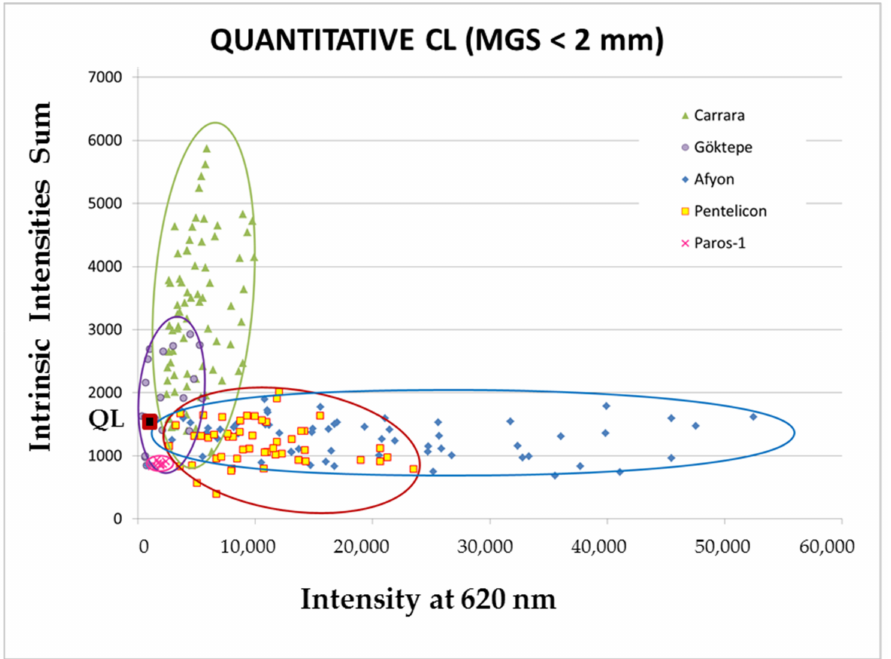
Figure 6. Representation of CL intensities measured in sample QL (red and black square) in the general quantitative CL diagram for the main classical fine-grained types of marble according to [24].